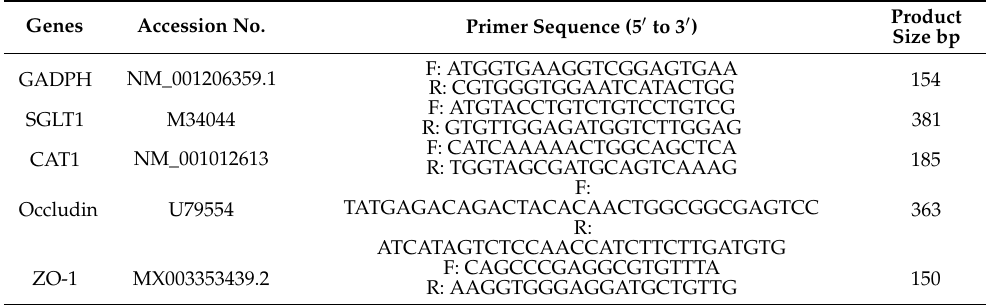
Table 2. Primers sequences of